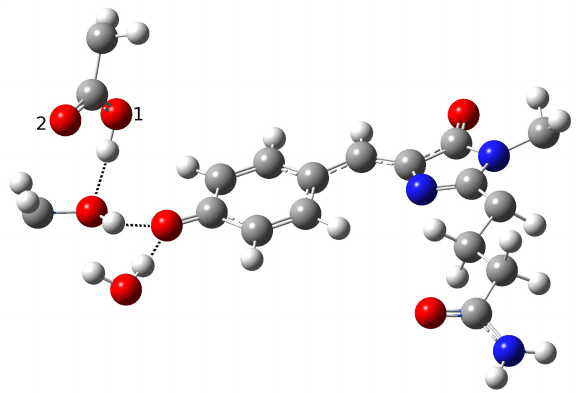
Figure 15. psamFP488 in anionic form optimized in the S 1 excited state. Table 6. Structural parameters (distance (Å) and angle (degrees) involved in the anionic chromophore form of the protein optimized in ground and excited